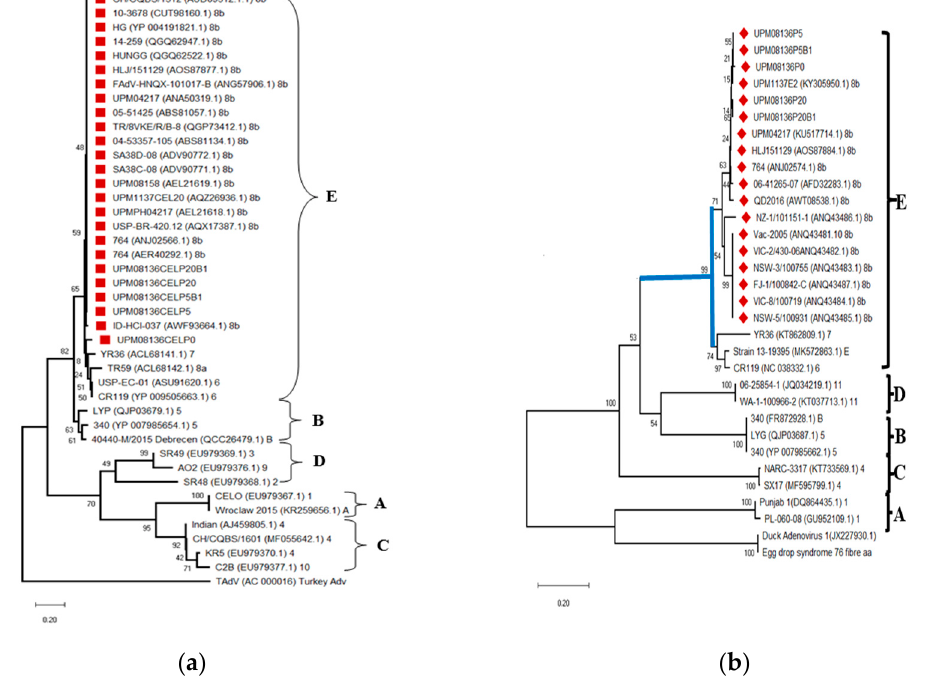
Figure 9. Phylogenetic tree based on amino acid residues of ( a ) hexon and ( b ) fiber genes of the bioreactor propagated FAdV isolates and reference strains from GeneBank. The analysis involved 42 and 32 amino acid residues of hexon and fiber genes, respectively. The evolutionary history was inferred using the neighbor-joining method. Evolutionary analyses were conducted in MEGA X. Each serotype is indicated by name while the FAdV serotype 8b is labeled in red. FAdV isolates branched off in the same clade while all study isolates clustered together with other serotype 8b isolates.